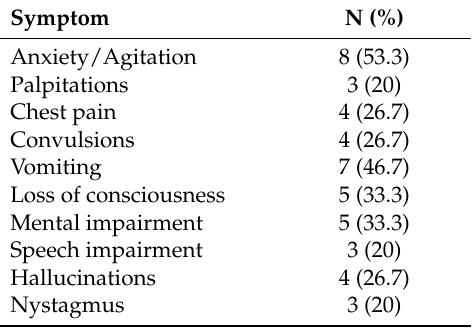
Table 4. Symptoms of the patients on